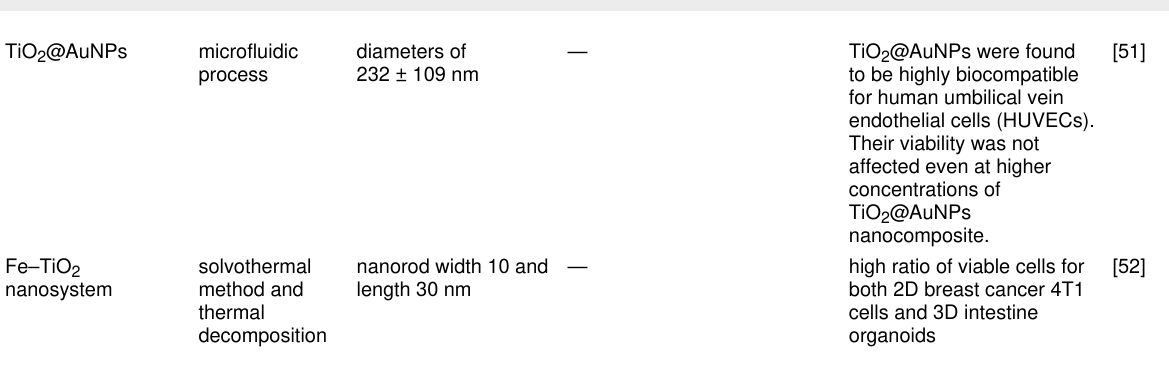
Table 1: Summary of the biocompatible nature of various TiO 2 nanomaterials. (continued) TiO 2